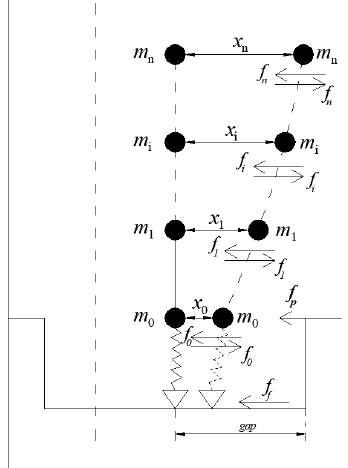
Figure 4. Model of the base-isolated structure with friction pendulum isolation bearing.